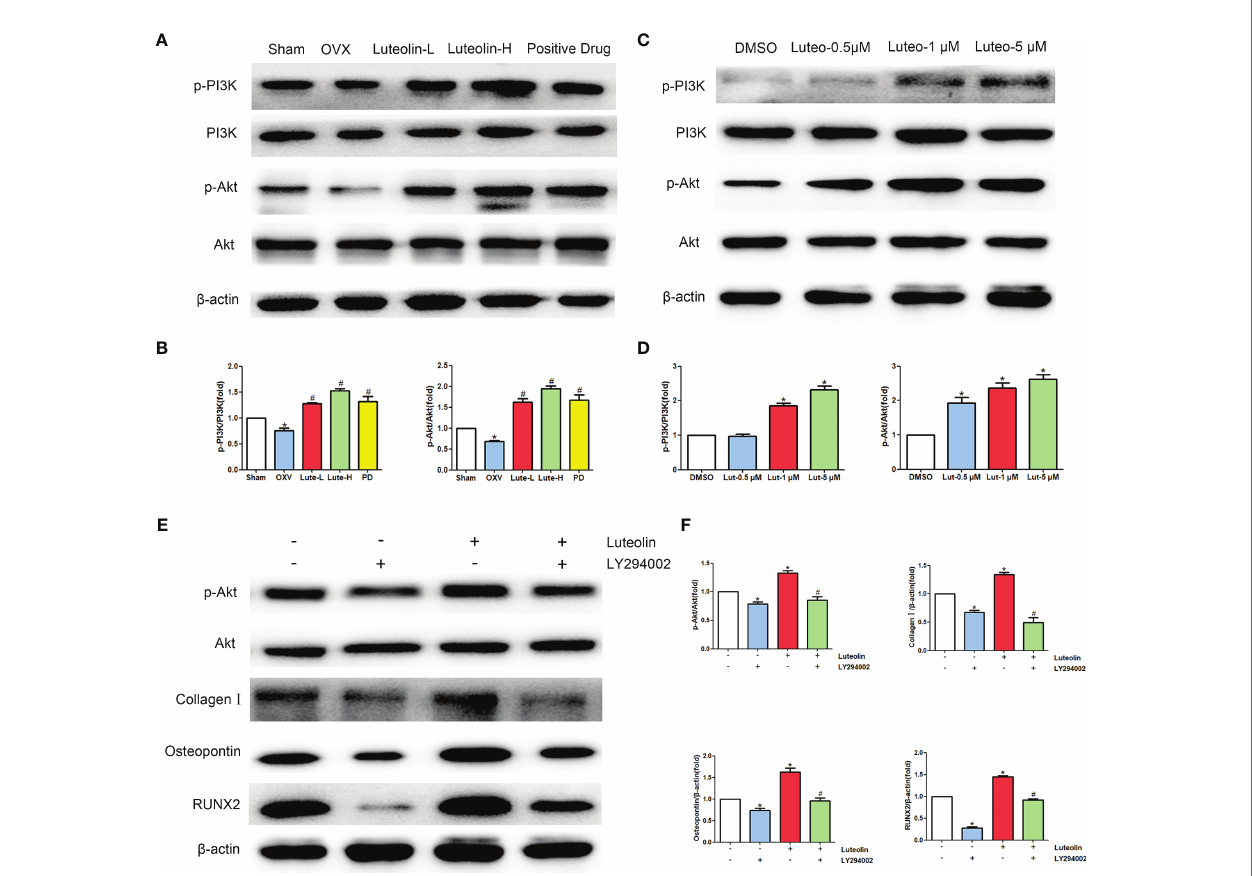
FIGURE 10 | Luteolin promotes the osteogenic differentiation of BMSCs by activating the PI3K/Akt signalling pathway. (A) The protein expression of p-PI3K, PI3K, p-Akt and Akt was detected by WB. (B) Comparative analysis of grey values from relevant protein bands; data are expressed as the mean ± SD from three independent experiments. Compared with the sham group, * p < 0.05; compared with the OVX group, # p < 0.05. (C) BMSCs were treated with luteolin at increasing concentrations (0.5 m M, 1 m M, and 5 m M) for 48 h, followed by an analysis of p-PI3K, PI3K, p-Akt and Akt protein expression levels with WB. (D) Comparative analysis of grey values from relevant protein bands; data are expressed as the mean ± SD from three independent experiments. Compared with the DMSO group, * p < 0.05. (E) BMSCs were incubated with or without 20 m M LY294002 (S1105, Selleck, USA) and 5 m M luteolin for 48 h, followed by an analysis of collagen I, osteopontin, RUNX2, p-Akt and Akt protein expression levels by WB. (F) Comparative analysis of grey values from relevant protein bands; data are expressed as the mean ± SD from three independent experiments. Compared with the DMSO group, * p < 0.05; compared with the luteolin only group, * p <